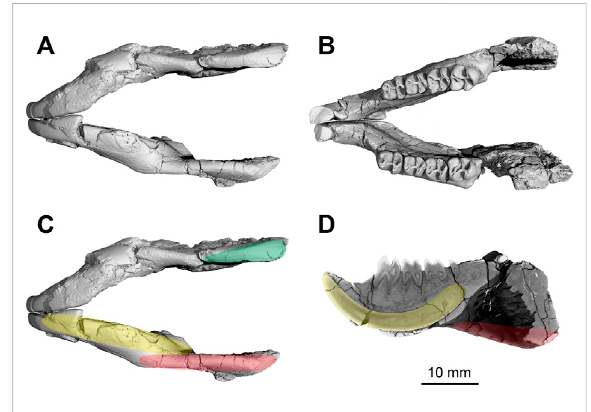
FIGURE 4 The low jaw of the type specimen of Yuomys cavioides (IVPP V 4796.1-2), showing the hystricognathous form. (A) , ventral view; (B) , occlusal view: (C) , yellow shadow indicating the plane of the incisive alveolus, red shadow indicating the plane of the angular process being distinctly lateral to the plane of the incisive alveolus, green shadow indicating expanded ventral edge of the angular process; (D) , virtual section of the right half mandible in medial view, yellow shadow indicting the posterior extension of the incisor, red shadow indicating the angular